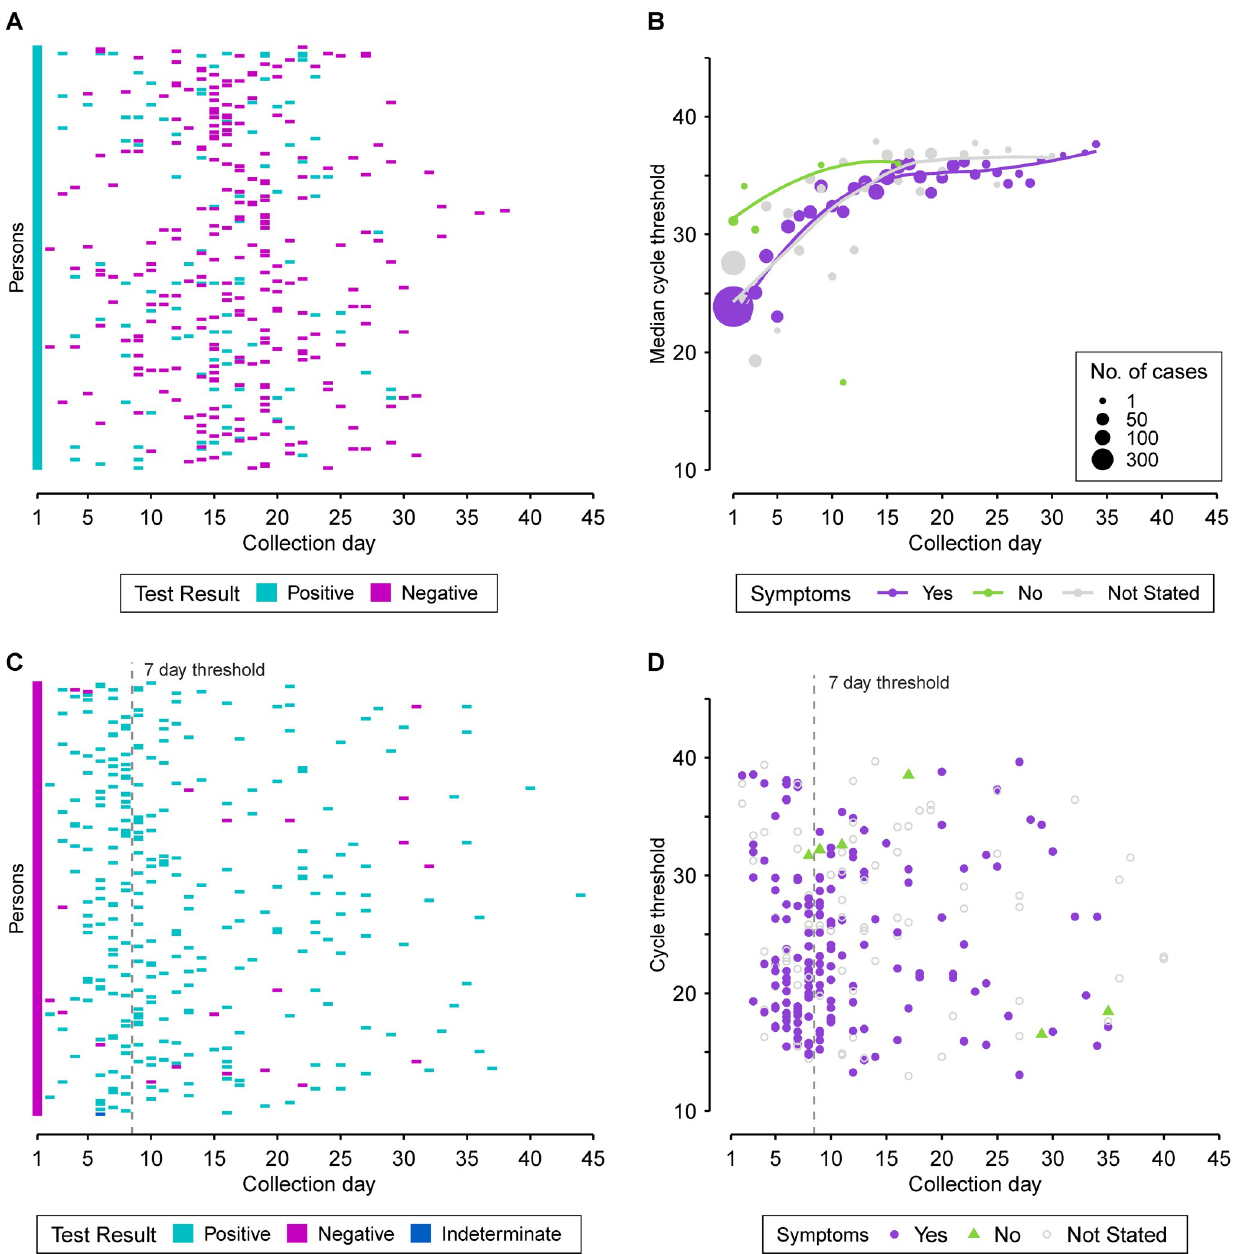
Fig 4. Molecular-based test results for individuals with specimens submitted to Public Health Ontario for SARS-CoV-2 testing, January 11 –April 22, 2020. Any positive result for an individual with multiple specimens collected on the same-day is displayed as positive, and indeterminate where there was an indeterminate result and no positive. (A) Pattern of results for individuals initially testing positive (day 1) with a subsequent negative result at a later date ( n = 199). Each individual is represented horizontally across collection days. (B) Median cycle threshold (C t ) by specimen collection day for those with day 1 positive results ( n = 578). Trend lines were fitted using locally estimated scatterplot smoothing (LOESS), with the asymptomatic curve excluding the day 11 outlier. (C) Pattern of results for individuals initially testing negative (day 1) with a subsequent positive result at a later date ( n = 255). A threshold 7 days following initial negative result differentiates episodes. (D) C t values by day of specimen collection for the first positive result obtained for an individual with a negative result on initial testing. Testing included one or more of the following: End-point PCR + Sanger sequencing of RNA-dependent RNA polymerase (RdRp) gene, rRT-PCR to detect the envelope (E) gene, RdRp gene and/or ORF1ab.